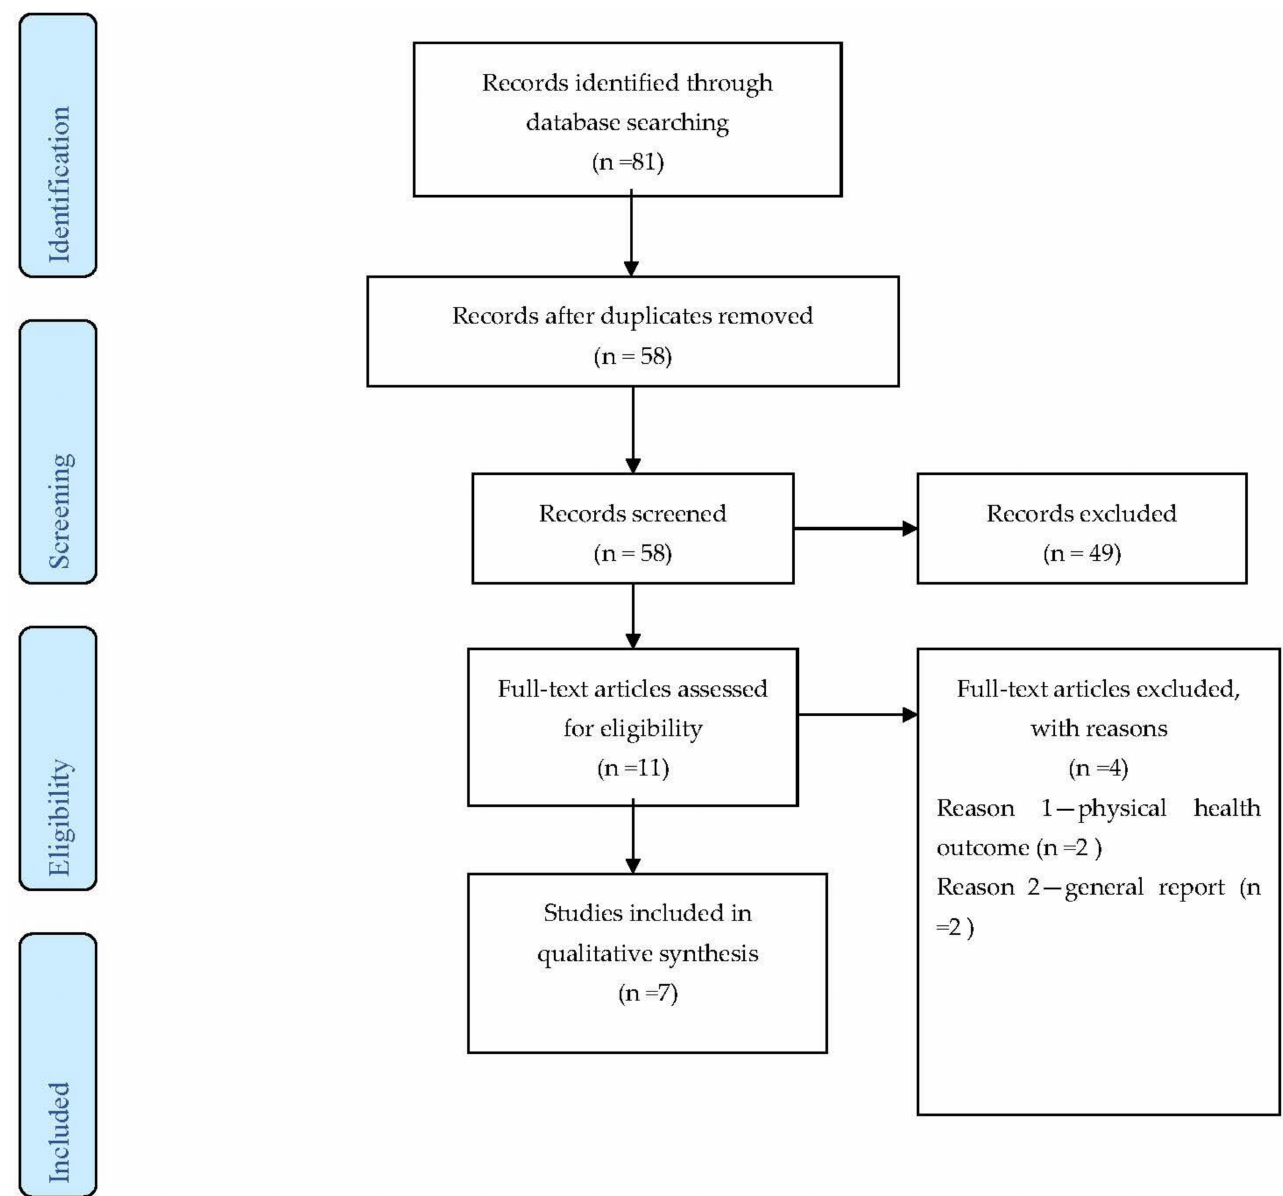
Figure 1. PRISMA flow diagram of the search and selection